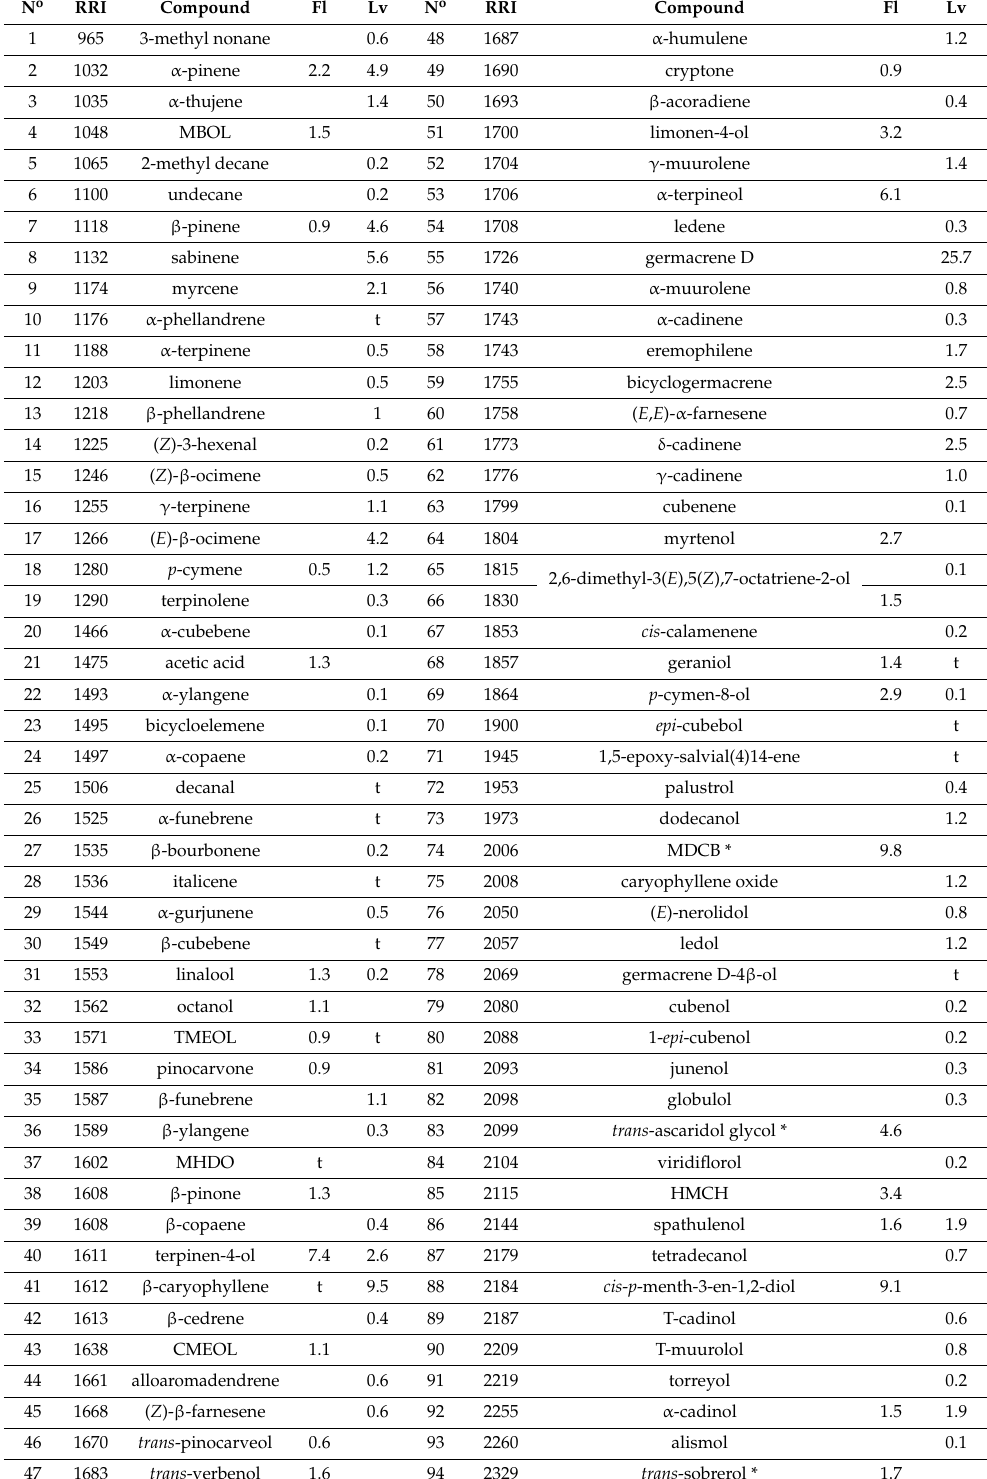
Table 2. Chemical composition of essential oils obtained from H. perforatum flowers (HEO Fl ) and leaves (HEO Lv ) a